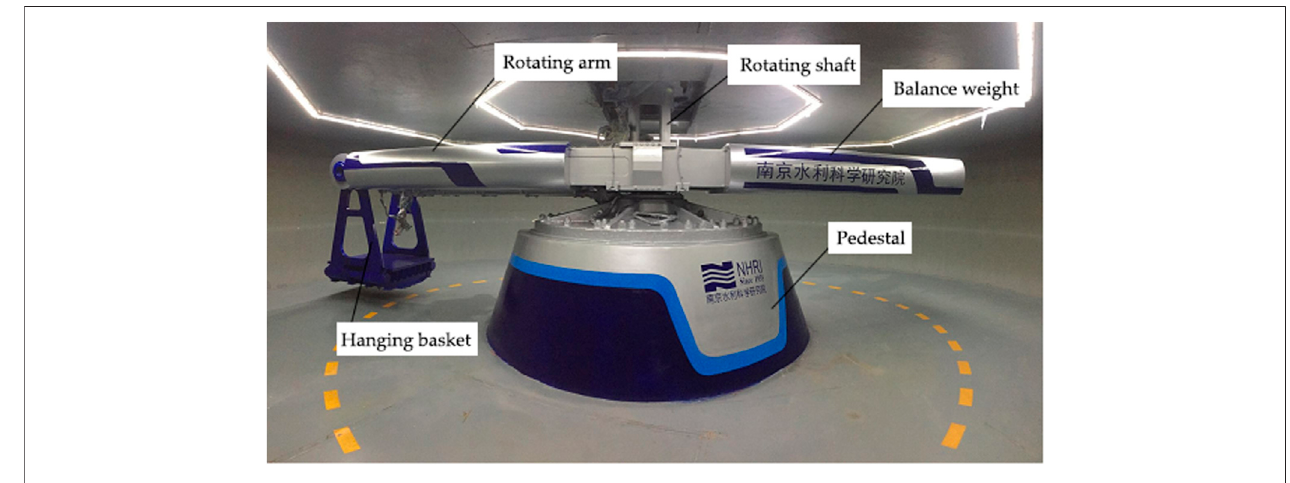
FIGURE 8 | NHRI-400 gt centrifuge.